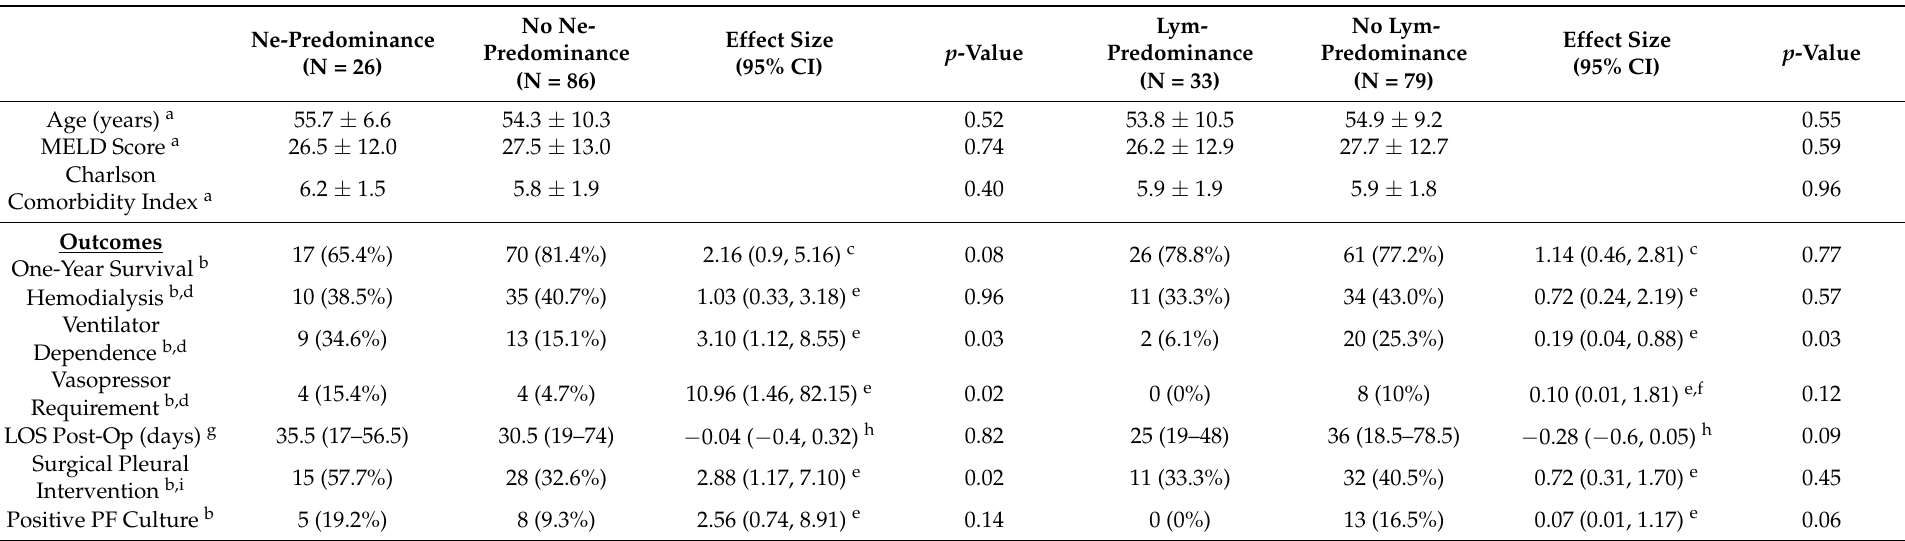
Table 4. Outcomes for pleural effusions with neutrophil (Ne) predominance Or lymphocyte (Lym) predominance vs. no